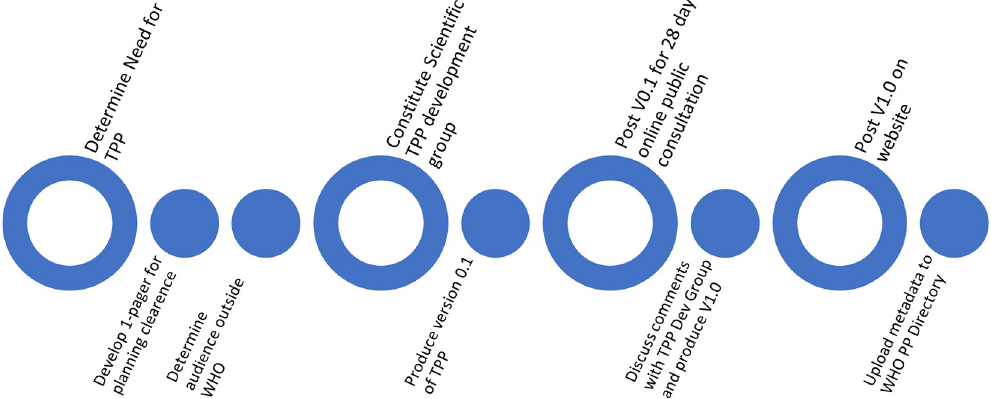
Fig 1. World Health Organization process to establish new target product profiles [8]. PP = product